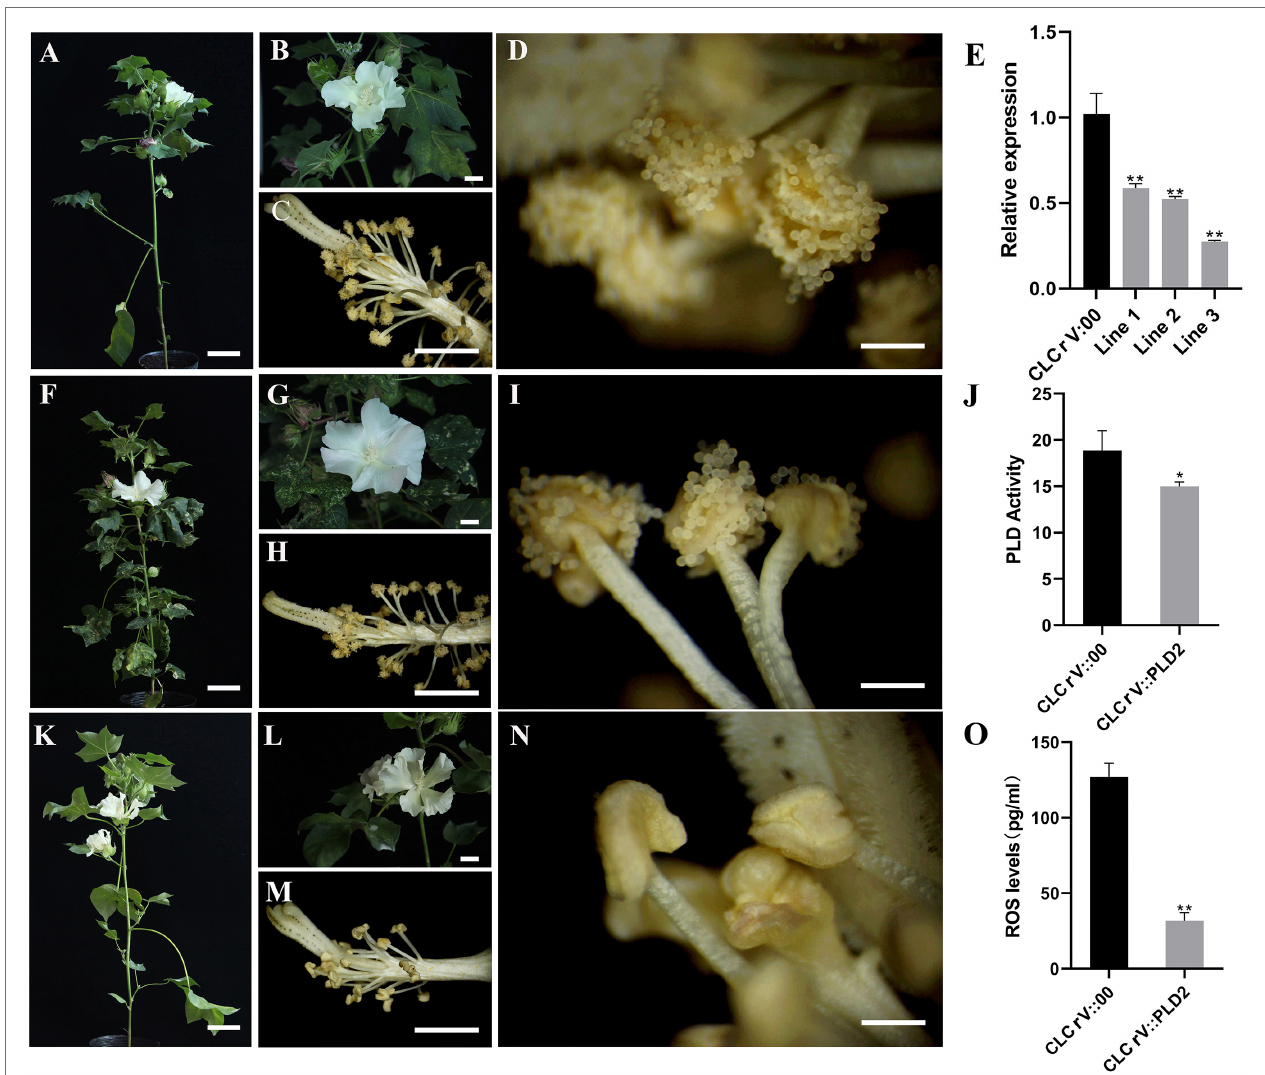
FIGURE 4 | Silencing of GhPLD2 -induced anther dehiscence defect and reduction in reactive oxygen species (ROS) content in upland cotton. (A–D) The cotton plant, flower, and anthers of CLCrV::00 are shown, respectively. (F–I) The cotton plant, flower, and anthers of CLCrV::PDS are shown, respectively. (K–N) The cotton plant, flower, and anthers of CLCrV::GhPLD2 are shown, respectively. (E) Expression levels of GhPLD2 in CLCrV::00 and CLCrV::GhPLD2 plants. GhHistone 3 was used as the reference gene for normalization. (J) Phospholipase D activity in CLCrV::00 and CLCrV::GhPLD2 plants. (O) ROS levels in CLCrV::00 and CLCrV::GhPLD2 plants. Error bars indicate the estimate of standard deviation in three independent replicates. Statistical analyses of experimental data were performed by t-tests. Asterisks showed that the value of p indicates significant (* p < 0.05) or very significant differences (** p < 0.01) as compared to that of the control. (A,F,K) scale bar = 8 cm; (B,C,G,H,L,M) scale bar = 1 cm; (D,I,N) scale bar = 1.5